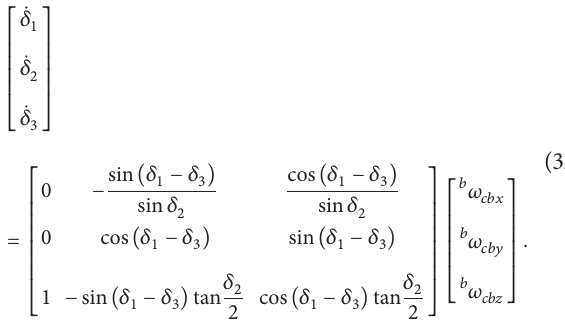
where C 𝑐 𝑏 represents transformation from the body frame to the cone